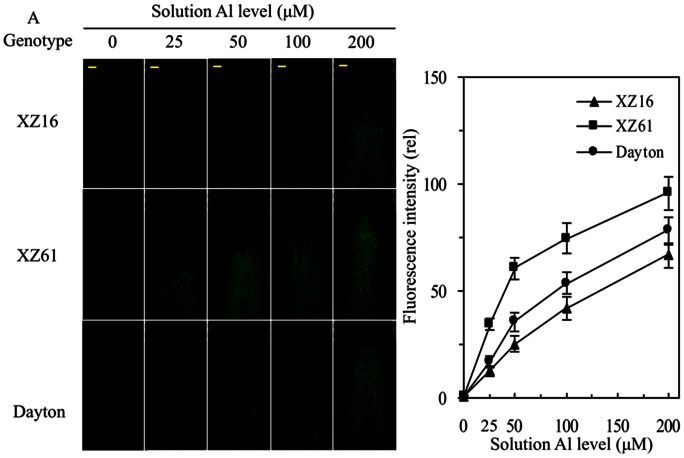
Al localization in barley roots exposed to different Al levels for 24 h.(A) Al was monitored by morin fluorescence using confocal laser scanning microscopy. Fluorescence intensity of image analysis was calculated using Image J software. (B) Seedlings were subjected to 0, 25, 50, 100 and 200 µM AlCl3, respectively, in 0.5 mM CaCl2 solution at pH 4.3 for 24 h, and then root tips (0–10 mm) were stained with morin. Images shown in the Figures are representative of more than fifteen seedlings per treatment. Bar = 100 µm. Data are means ± SD (n = 5).